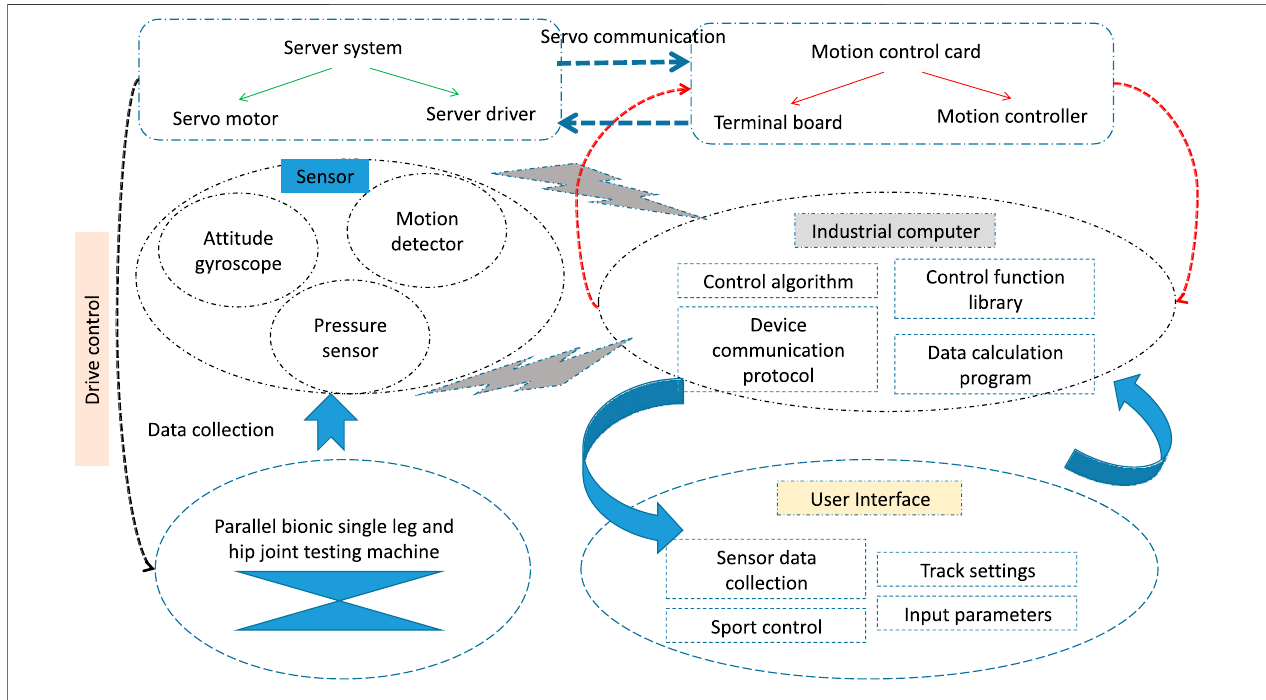
FIGURE 2 | System framework of the experimental